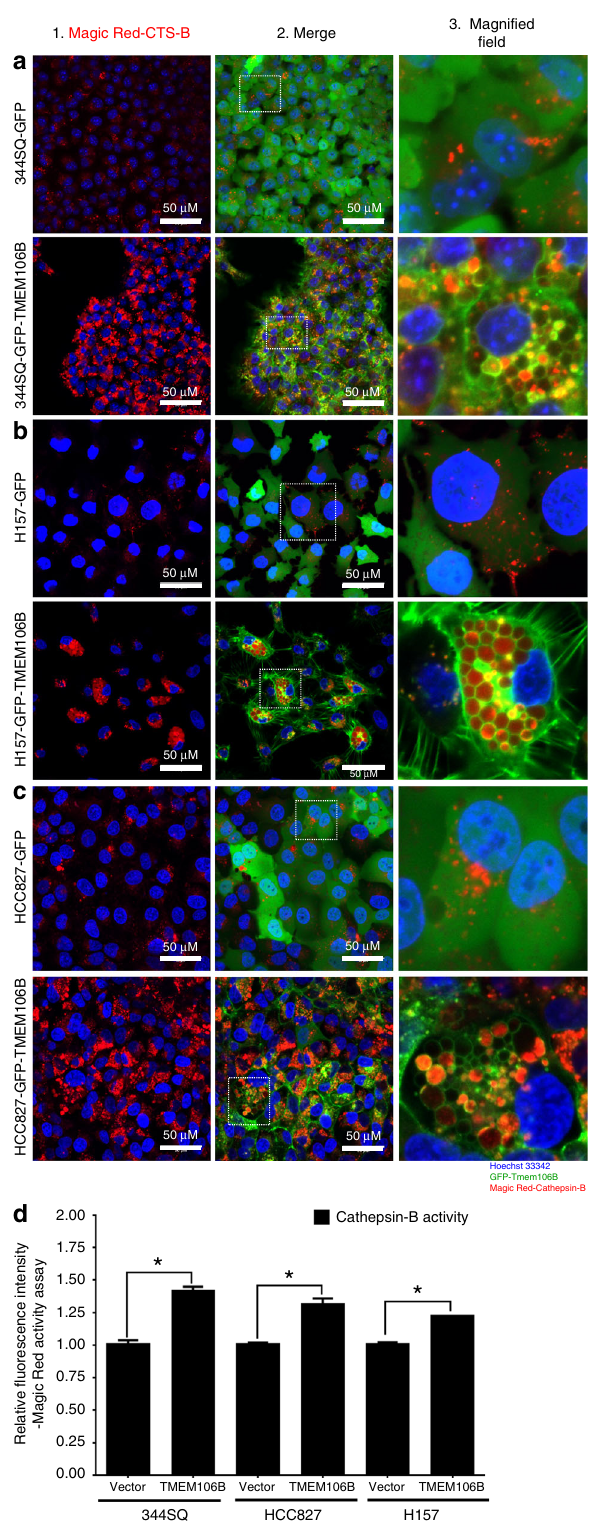
Fig. 4 TMEM106B-induced lysosomes are loaded with catalytically functional cathepsins. a – c Cells expressing GFP only or GFP-tagged TMEM106B were incubated with Magic Red Cathepsin B reagent to stain for activity of cathepsin B and counter stained with Hoechst33342. Cell were imaged live in real time as indicated. d Quanti fi cation of fl uorescence intensity corresponding to cathepsin B activity as analyzed by Magic Red Cathepsin B activity assay in different cells. All asterisks indicate statistical signi fi cance by t test ( n ≥ 3, * p ≤